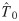
Per-subject geometric means of unoccluded time headway T^0, occluded time headway T^D and occlusion duration o^D.